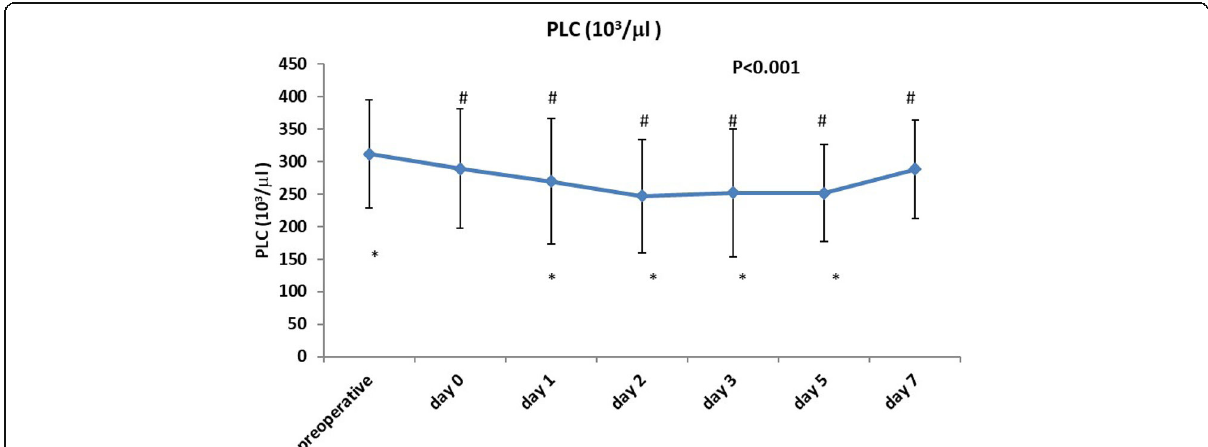
Fig. 1 PLC changes during 1st week of ICU stay. Data presented as means; error bars represent standard deviation. p < 0.001 = highly significant. The number sign (#) indicates highly significant difference compared to preoperative PLC. The asterisk (*) indicates highly significant difference compared to day 0 PLC